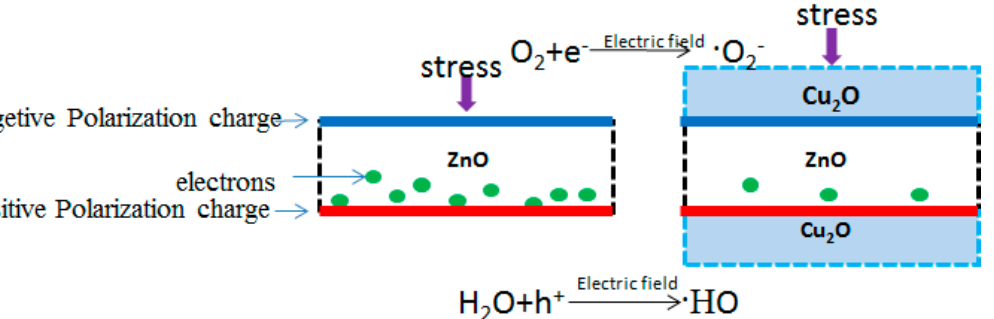
Figure 8. The mechanism of the enhancement of decoloration rate (DR) by depletion layer.